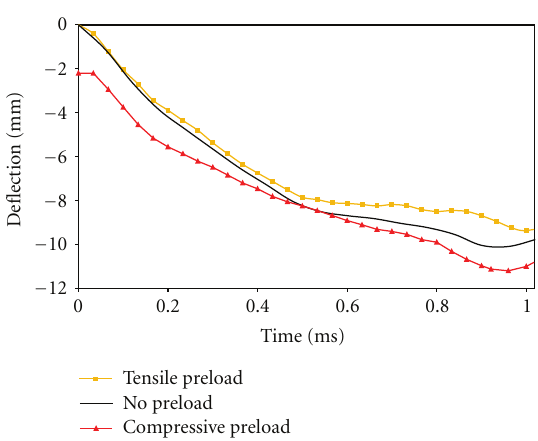
Figure 12: Predicted deflection of plate centre versus time under bird impact with